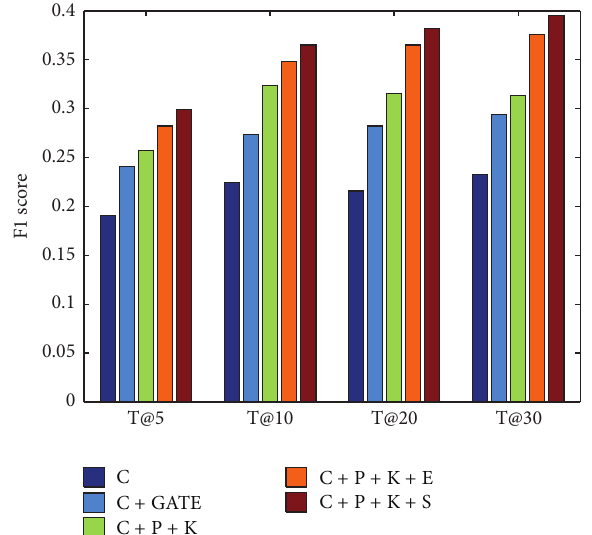
Figure 8: Recommendation F1 score of different profile factors and subclasspopularitypredictionmethods. Remark. C:content,P:place name, K: key person name, GATE: entities name using GATE tool, E: popularity prediction using three-time exponential smoothing, and S: popularity prediction using spectral analysis (employed by NEMAH).